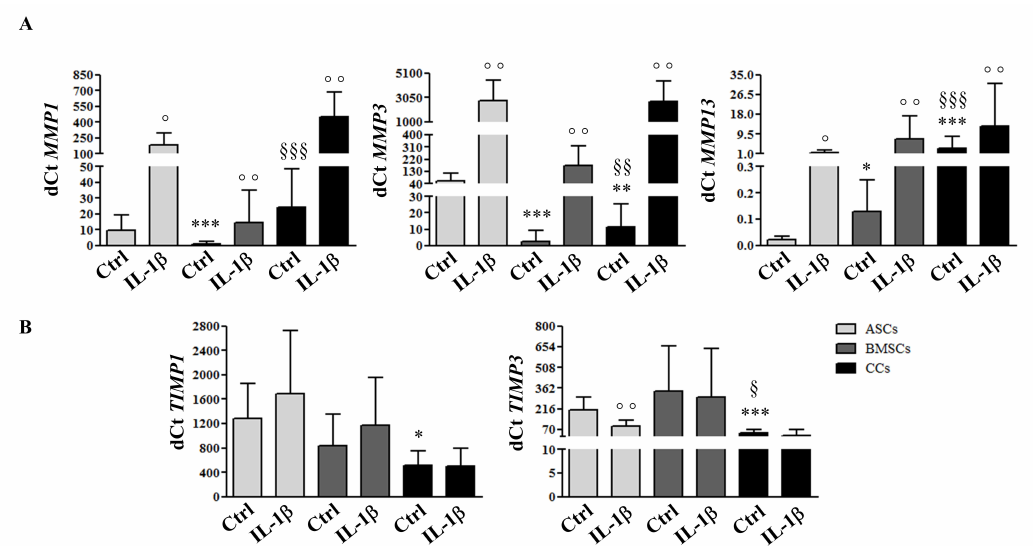
Figure 4. ECM remodeling molecular response to a pro-inflammatory stimulus. Expression of metalloproteases ( MMP1, MMP3, MMP13 ) ( A ) and their inhibitors ( TIMP1, TIMP3 ) ( B ) in adipose (ASCs)-, bone marrow (BMSCs)-derived MSCs, and cartilage cells (CCs) obtained from the same donors, assessed by quantitative real-time PCR at P3 before and after IL-1 β stimulation. * p < 0.05, ** p < 0.01, *** p < 0.001 vs. ASCs, § p < 0.05, §§ p < 0.01, §§§ p < 0.001 vs. BMSCs, ◦ p < 0.05, ◦◦ p < 0.01 vs. control. Data are expressed as mean ± SD ( n =